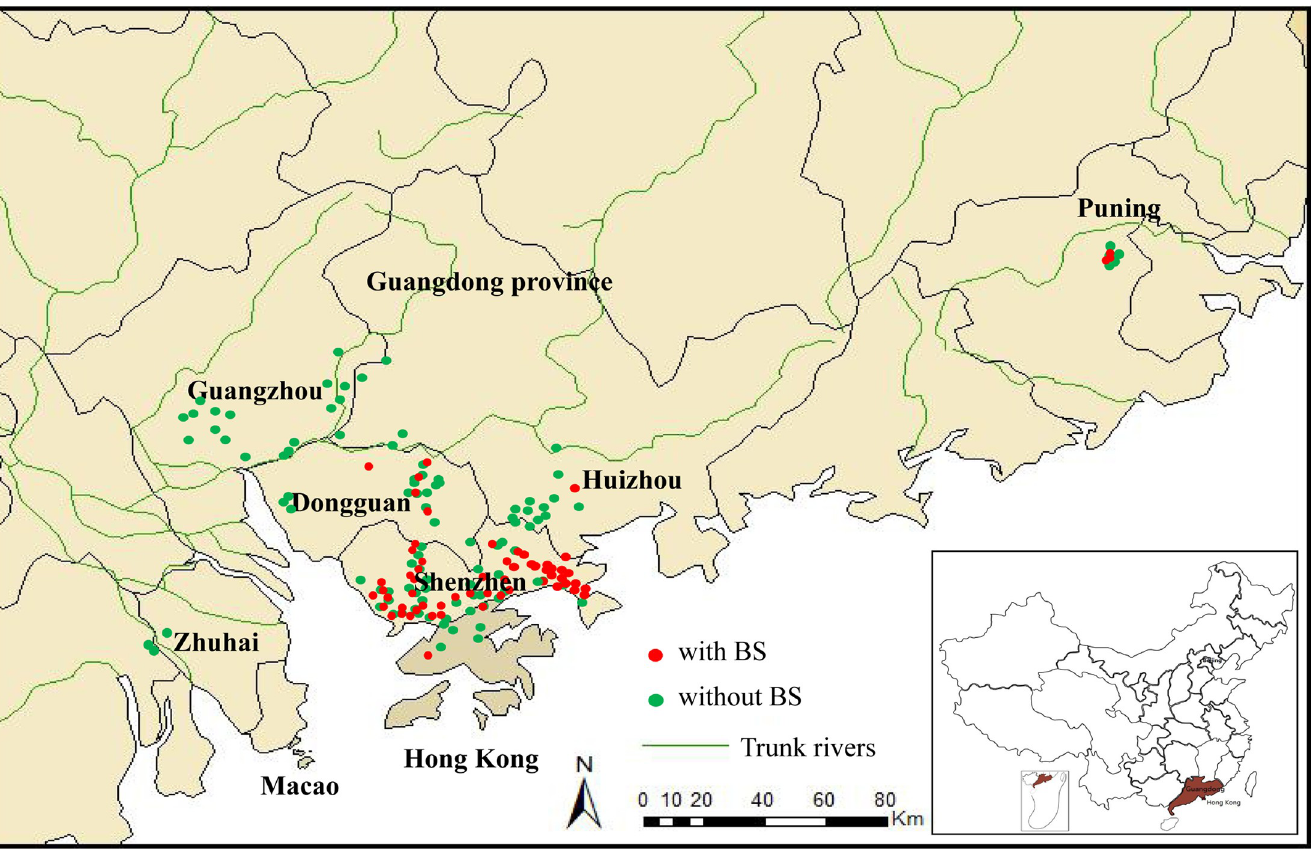
Fig 2. The distribution of B . straminea in Dongguan, Shenzhen, Huizhou Puning and Hong Kong Cities. Major cities and all investigated sites (positive and negative for B . straminea ) were marked on the map. Green dots: negative sites; Red squares: sites found B . straminea . This map was created using ArcGIS.